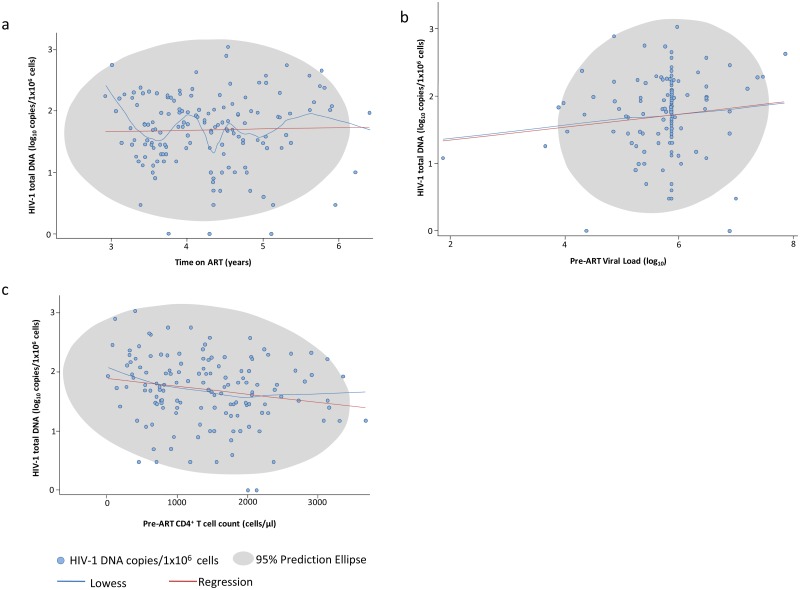
Scatterplots showing associations between HIV-1 DNA log10 copies/106 cells and a: Time on ART in years; b: Pre-ART HIV-1 RNA copies/ml and c: Pre-ART CD4 count in cells/mm3.LOcally WEighted Scatter-plot Smoother (LOWESS) and linear regression prediction lines shown in blue and red, respectively.; grey area shows the 95% prediction elipse.